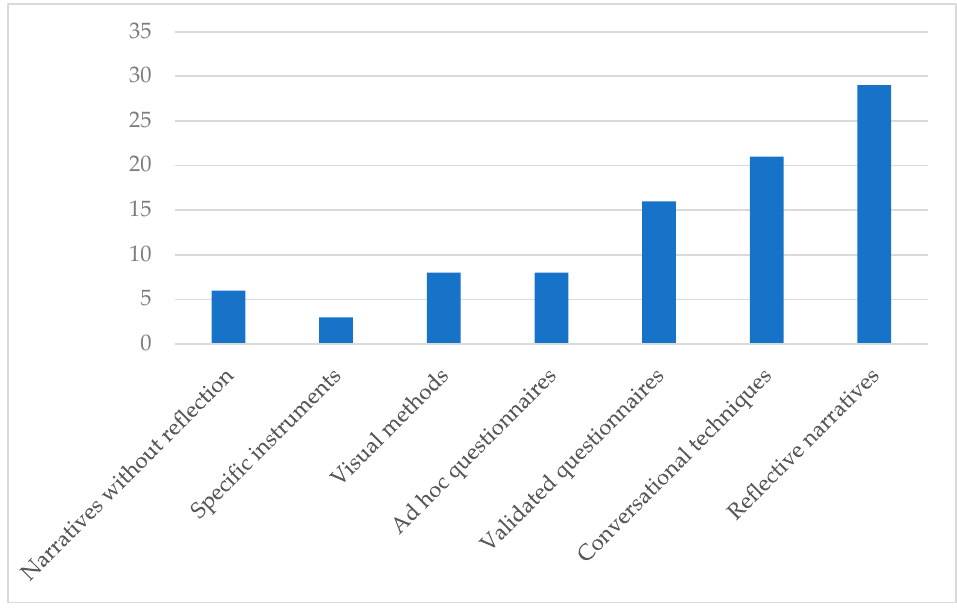
Figure 6. Frequency of use among the research instruments.